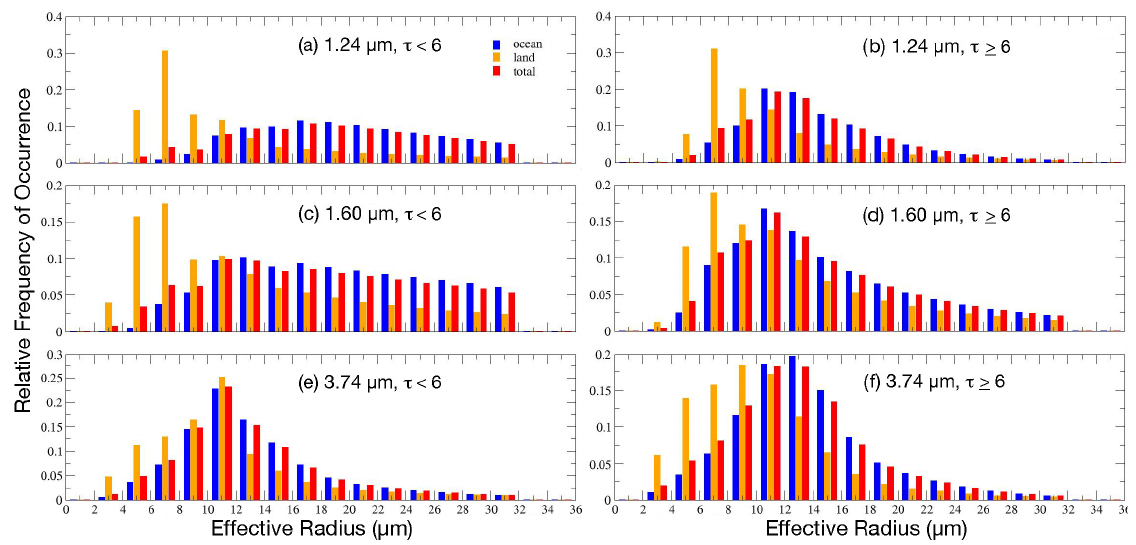
Figure 17. Probability distributions of CV1S liquid water droplet effective radii from ( a , b ) 1.24 µm, ( c , d ) 1.60 µm, and ( e , f ) 3.74 µm for optical depth, τ , ranges; left: 0–6 and right: 6–150, April 2013.